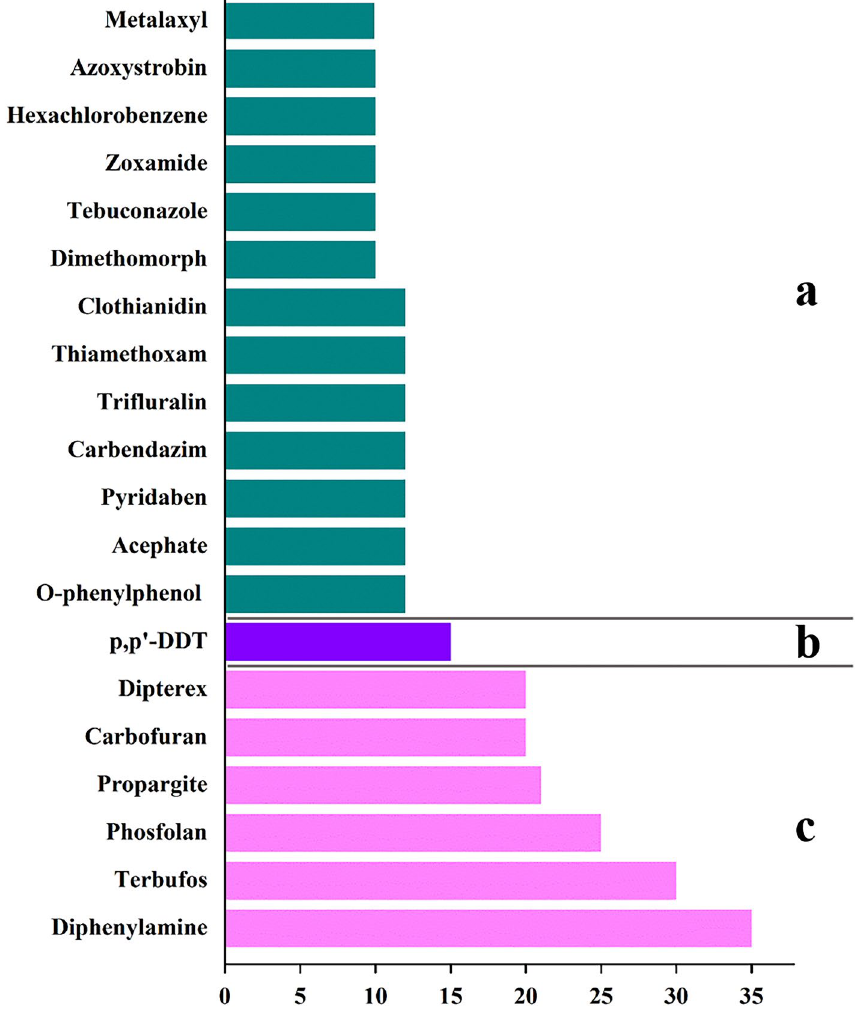
Figure 3. Risk scorings for 20 detected pesticides in CR. ( a ): Low-risk group that scored below 15.0; ( b) : Medium-risk group that scored between 15.0 and 19.9; ( c ): High-risk group that scored above 20.0.